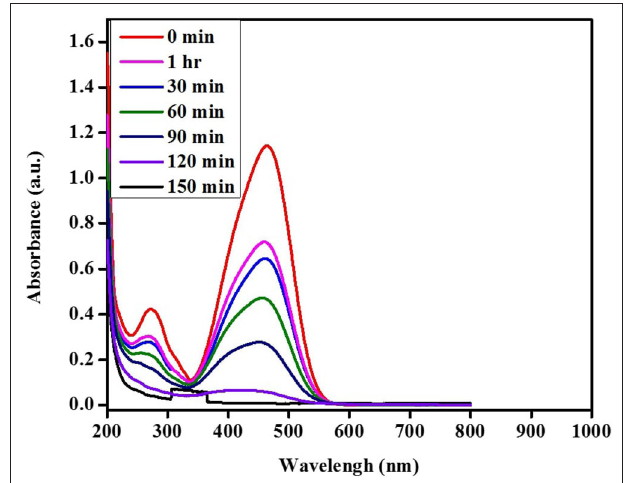
FIGURE 14 | Absorbance spectra of photocatalytic degradation pattern of MO